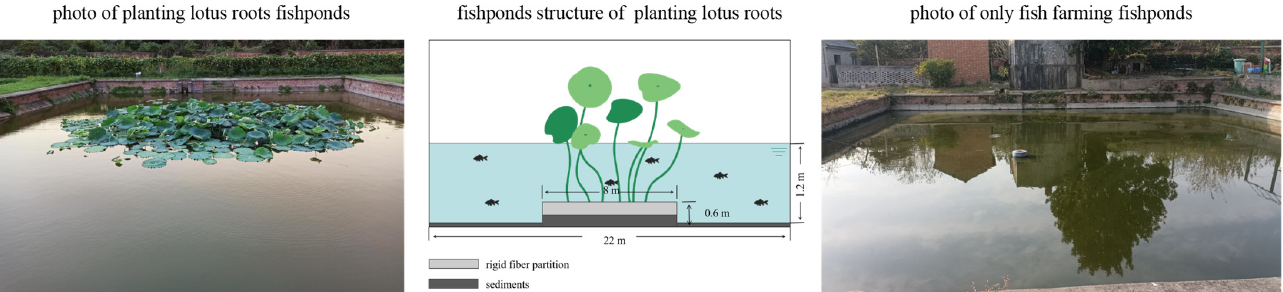
Figure 1. Planting lotus root group ( left ), lotus ridge structure ( middle ), and only fish farming group ( right ) in yellow catfish culture experimental ponds. To prevent lotus roots from overgrowing the whole pond, the sediment around the PL pond was gathered towards the middle to form an area for planting lotus roots. A rigid fiber partition was used to enclose the root planting area and was inserted into the silt for 0.60 m. The shape surrounded by the partition was circular and had a diameter of 8 m.